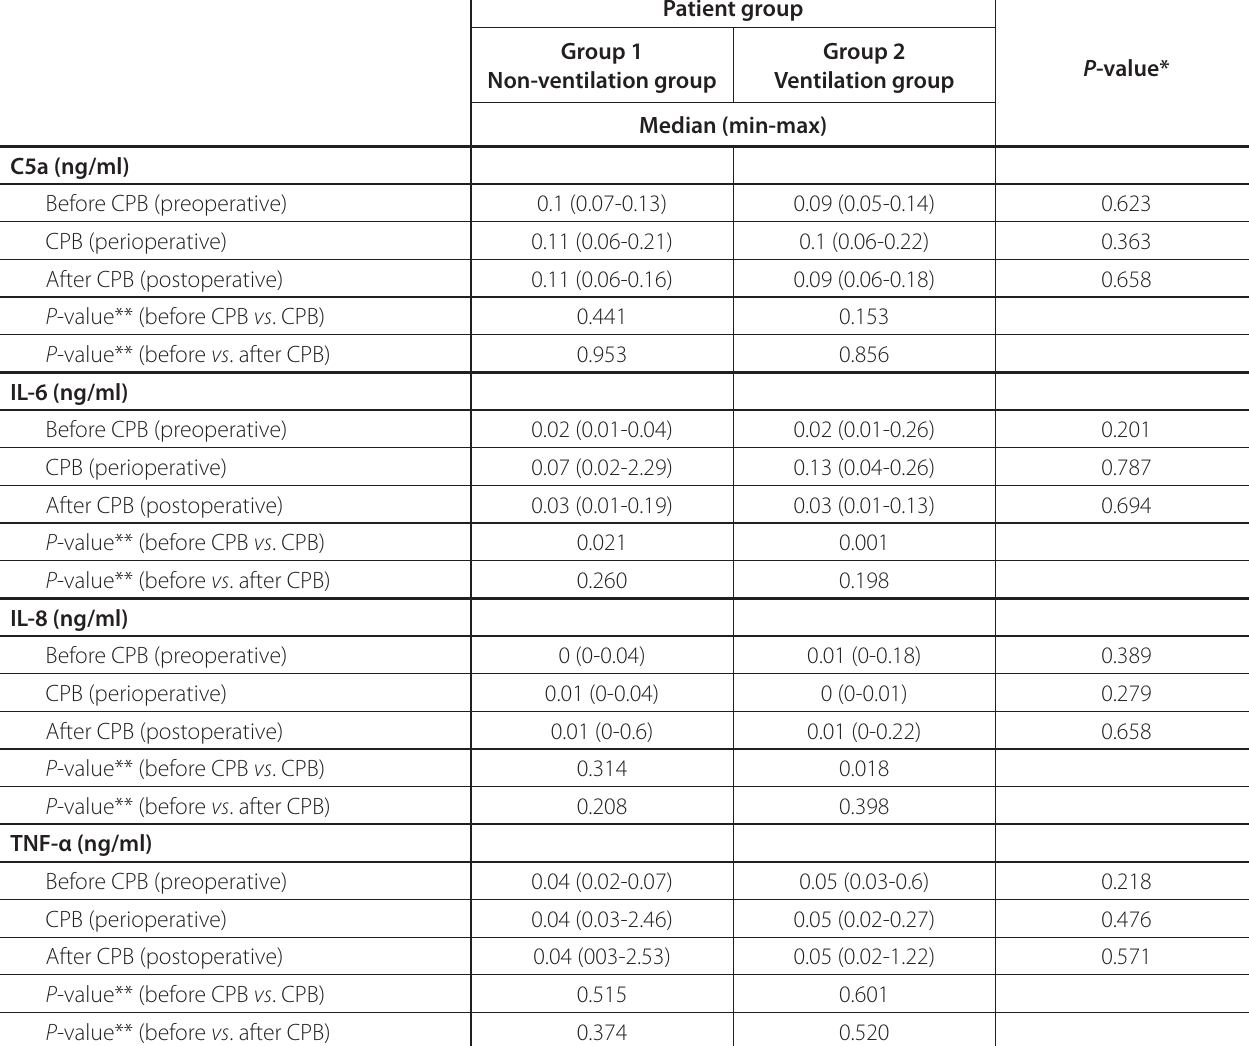
Table 2 . C5a, IL-6, IL-8 and TNF-α measurements and group